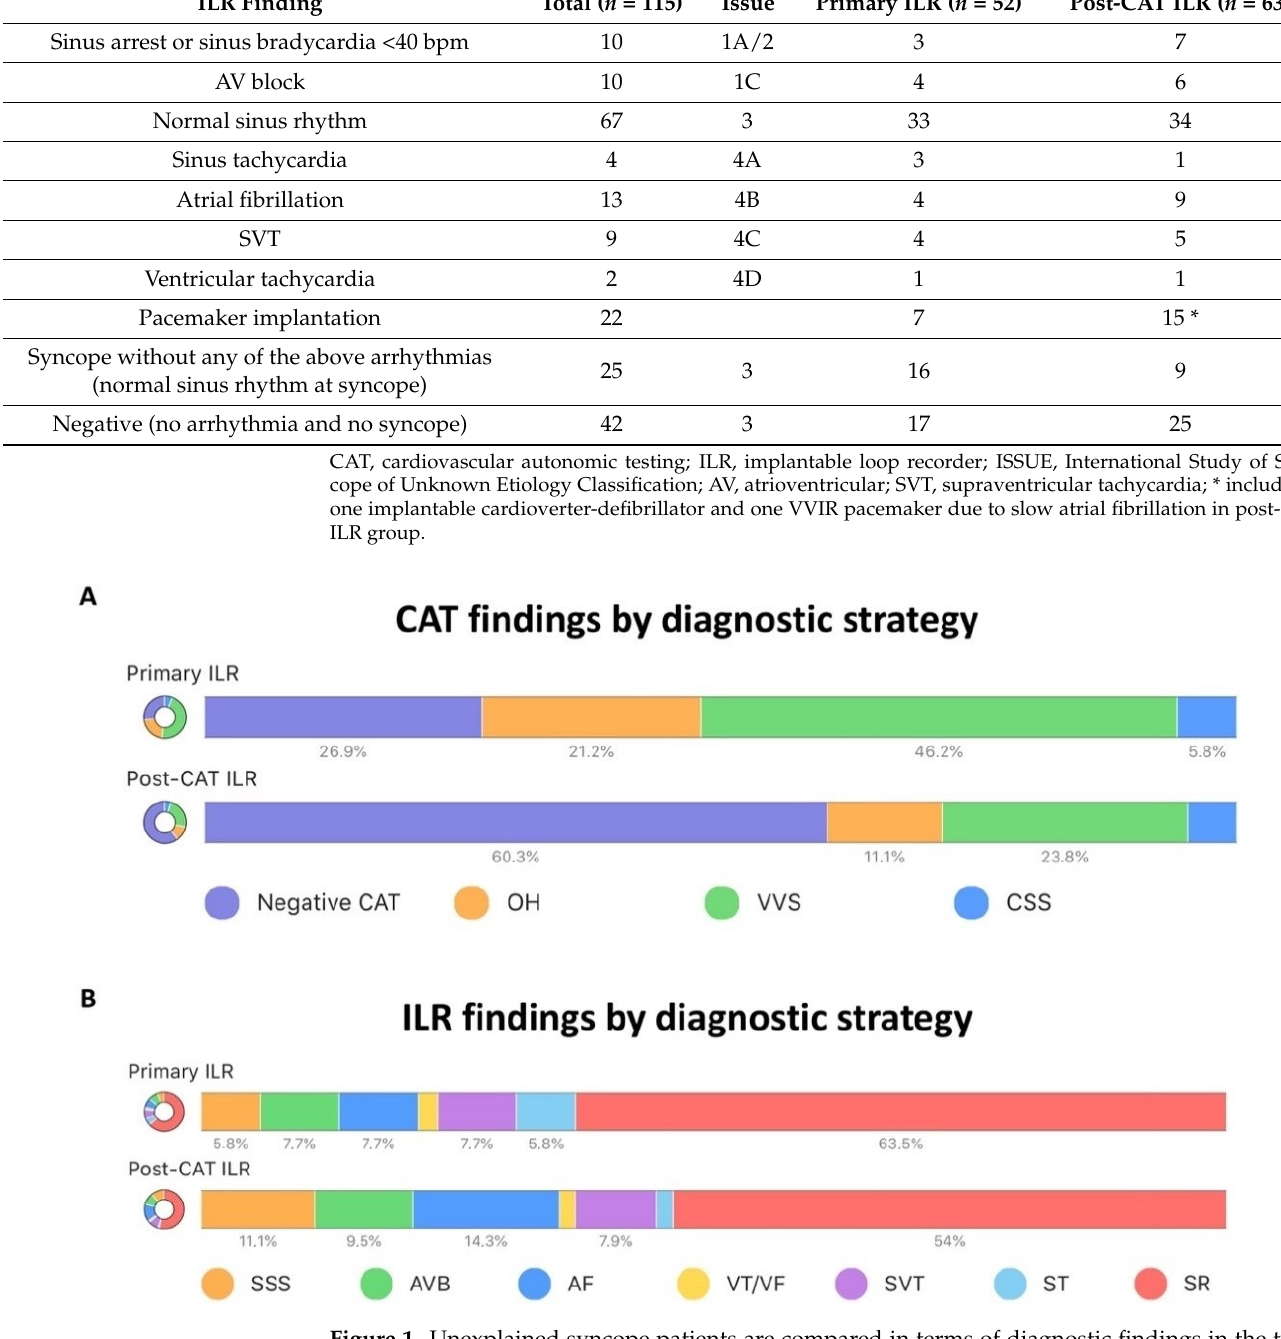
Table 2. ILR findings in patients implanted before and after CAT (46 patients experienced syncope during the monitoring period).